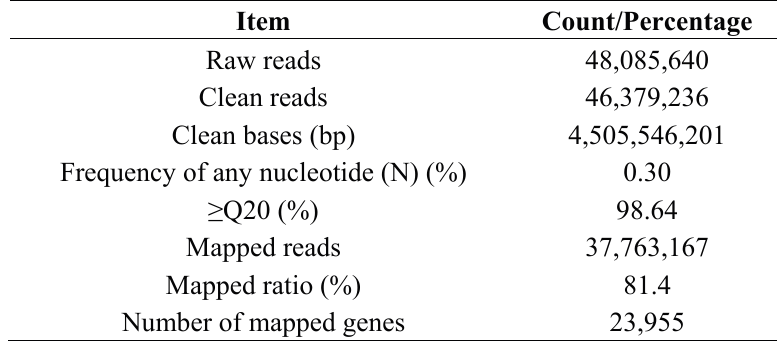
Table 1. Basic statistics for the RNA-seq data of “Cuiyu” sand pear fruit